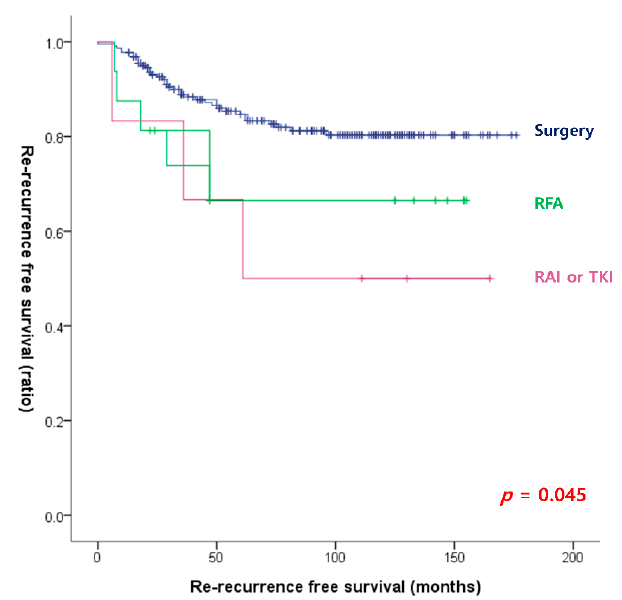
Figure 1. Re-recurrence-free survival curves according to the management at the first recurrence Figure 1. Re ‐ recurrence ‐ free survival curves according to the management at the first recurrence (log-rank p = (log ‐ rank p = 0.045).